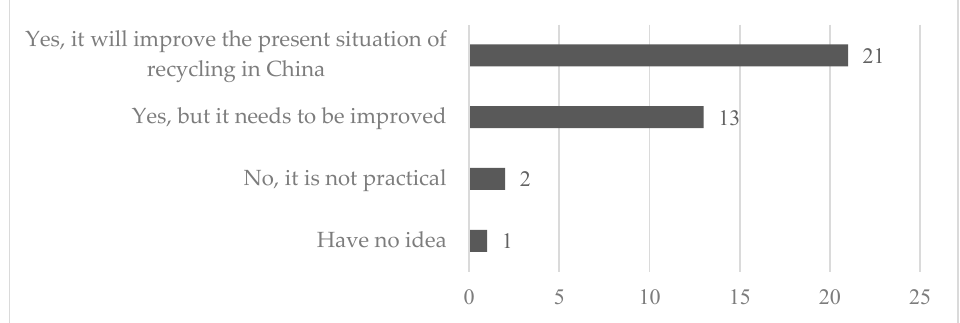
Figure 8. Respondents’ views on the feasibility of the proposed model.